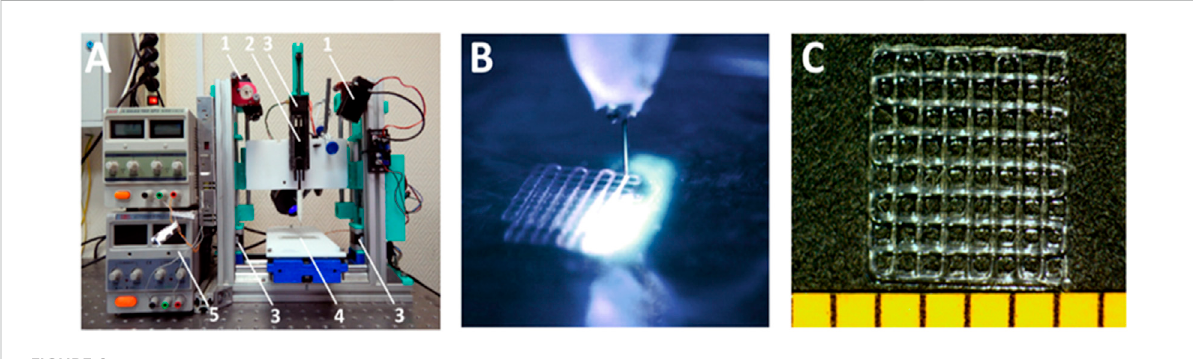
FIGURE 2 3D extrusion printing with simultaneous photocross-linking. (A) extrusion setup: 1) CW lasers; 2) extruder; 3) stepper motors; 4) sample compartment; 5) power supply. (B) photocuring of extruded hydrogel. (C) hydrogel structure on the substrate.